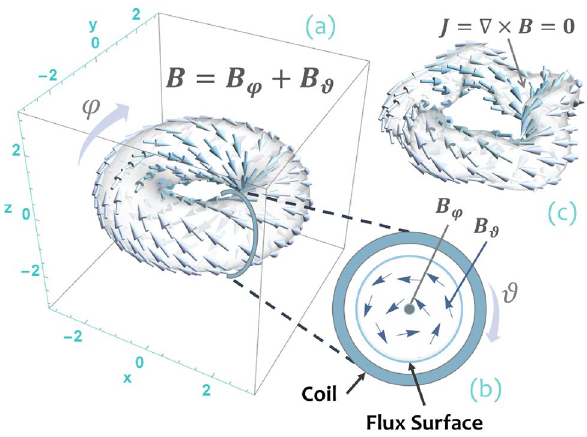
Figure 1. ( a ) and ( b ): magnetic field configuration in an axially symmetric tokamak. The total confining magnetic field B = B ϕ + B ϑ is given by an axial (toroidal) component B ϕ produced by external coils plus a poloidal component B ϑ generated by an electric current flowing in the ϕ -direction. This current is sustained by the confined plasma itself. Here, ϕ and ϑ denote toroidal angle and poloidal angle respectively. For simplicity, the reactor vessel separating external coils from the confinement region is not shown. ( a ) The total magnetic field B over a flux surface (cid:31) = constant such that B · ∇ (cid:31) = 0 . ( b ) Schematic view of toroidal component B ϕ and poloidal component B ϑ on a cross section ϕ = constant . ( c ) Schematic representation of a stellarator: the confining magnetic field is asymmetric and entirely produced by external coils, implying that the associated electric current vanishes in the confinement region, J = ∇ × B = 0 . Figure created using Wolfram Mathematica 12.2